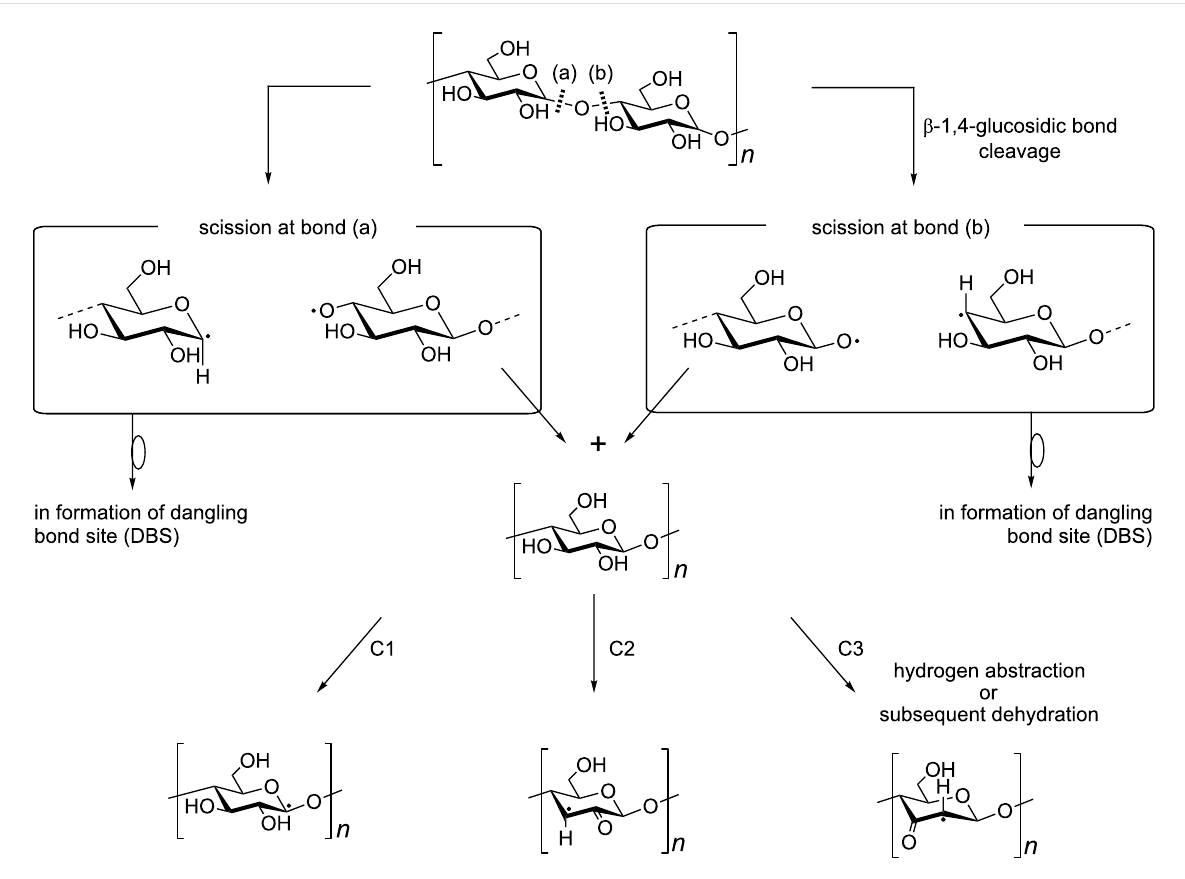
Figure 1: Structures of discrete mechanoradicals and the reaction sequence for their formation from cellulose